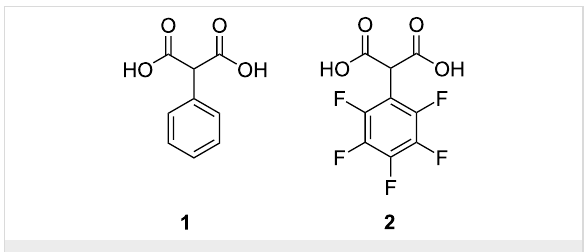
Figure 1: Phenylmalonic acids.